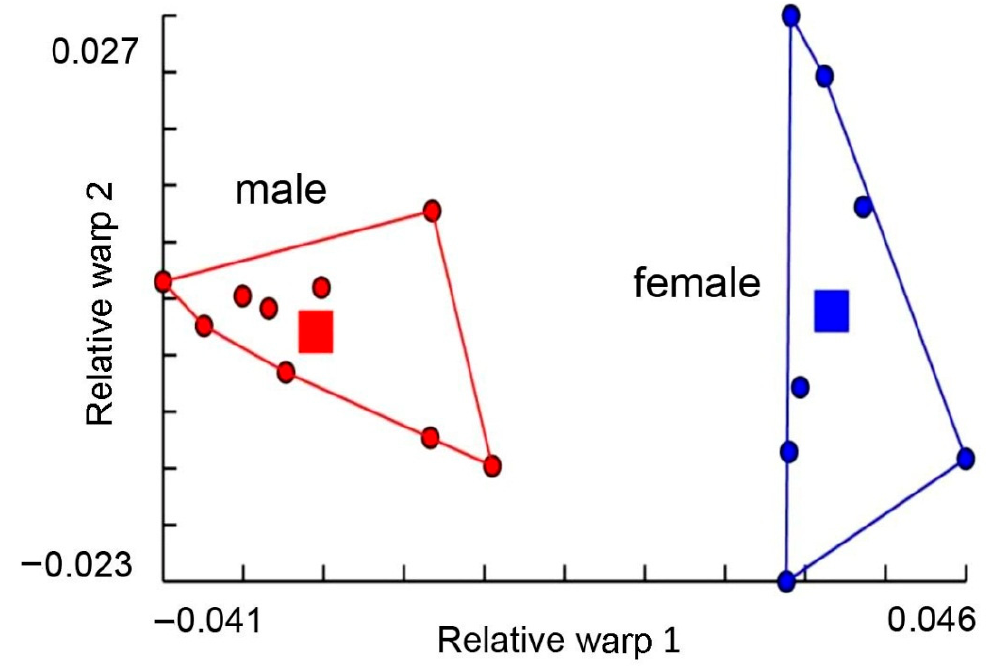
Figure 6. Morphospace of males and females of Haematobosca aberrans Pont, Duvallet & Changbunjong, 2020 based on wing shape variables. The horizontal axis is the first relative warp (RW1), and the vertical axis is the second relative warp (RW2).